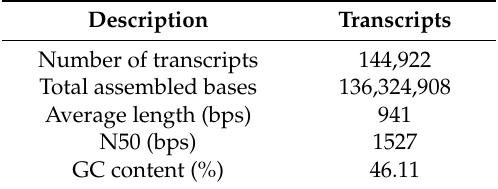
Table 1. Transcriptome assembly statistics for L. longituba .